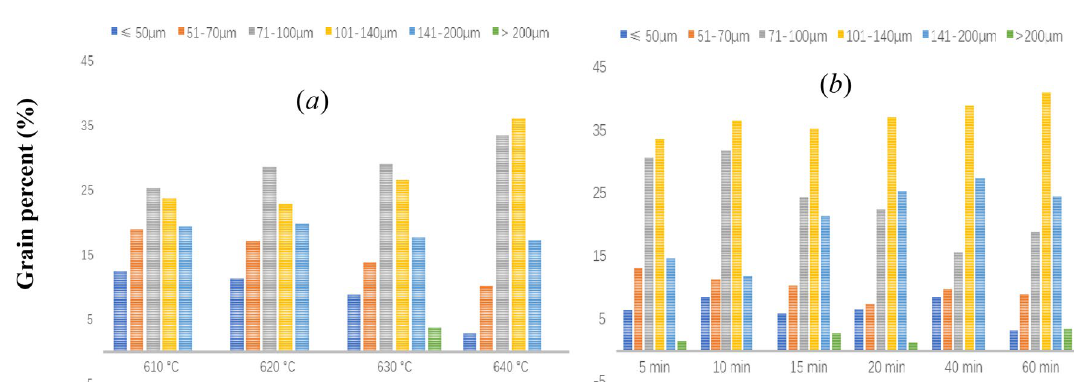
Figure 2. The percent composition of the grains in Al–Fe–Cu alloy held for 30 min at different temperature ( a ), and heated at 630 °C for various holding times ( b